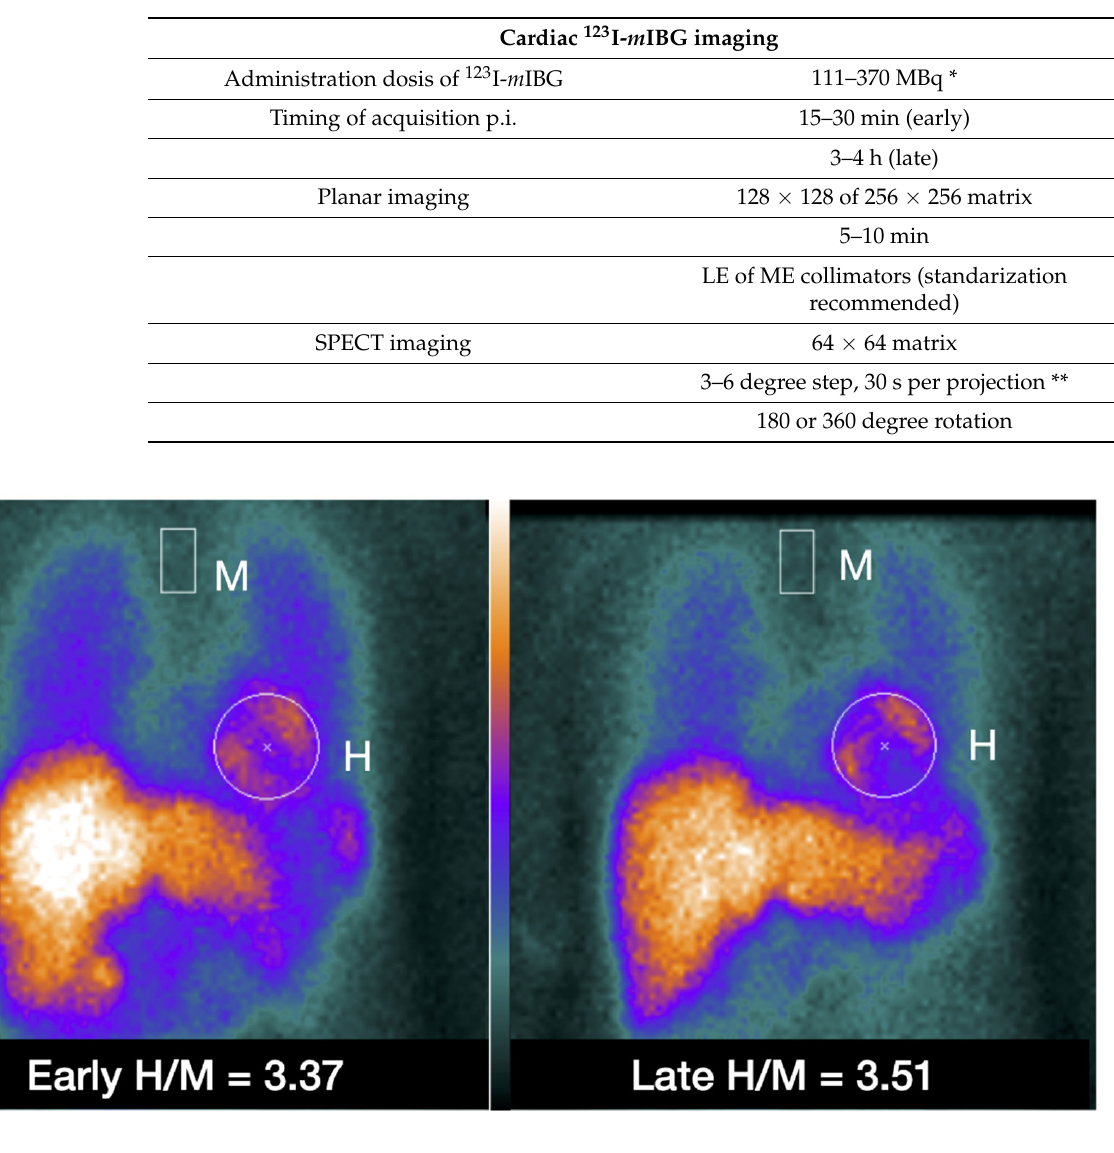
Figure 2. Example of placing a circular or elliptical region of interest (ROI) over the heart (H) and fixed rectangular mediastinal ROI placed on the upper part of the mediastinum (M) for calculating heart-to-mediastinum ratio (H/M). The same ROIs are placed on early and late images to calculate H/M and washout. The H/M outcomes are standardized to the ME-collimator condition.